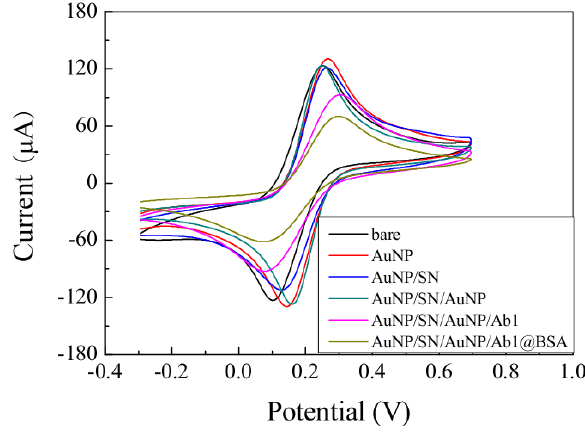
Figure 3. CVs of bare electrode (black curve) and electrodes modified with different surface: AuNP (red curve), AuNP/SN (blue curve), AuNP/SN/AuNP (green curve), AuNP/SN/AuNP/Ab1 (magenta curve), AuNP/SN/AuNP/Ab1@BSA (black yellow